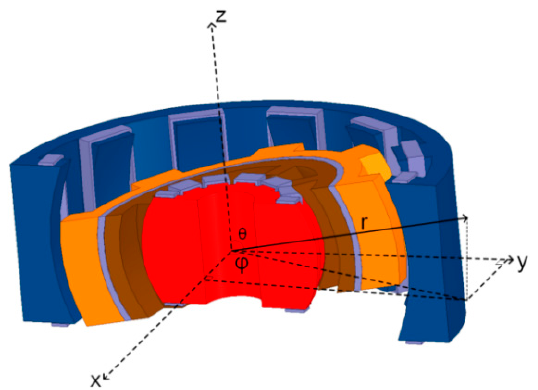
Figure 2. DSRM in deflection motion.